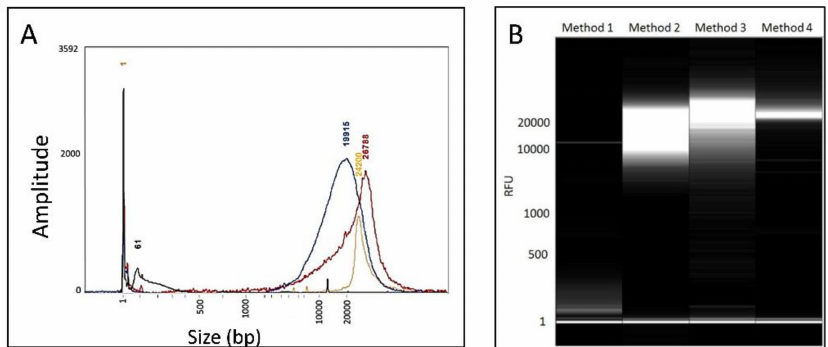
Figure 2. DNA fragment size analyses for four extraction methods of Williamsia sp. 1138 cells cultured in 4.5% MSM-G. ( A ) Amplitude readout from the Fragment Analyser and ( B ) images generated from the automated capillary electrophoresis system of the Fragment Analyser with size standards (bp) marked. Method 1: Isolate II Genomic DNA kit (Bioline) (_ peaks at 61 and 12,000 bp; Method 2: